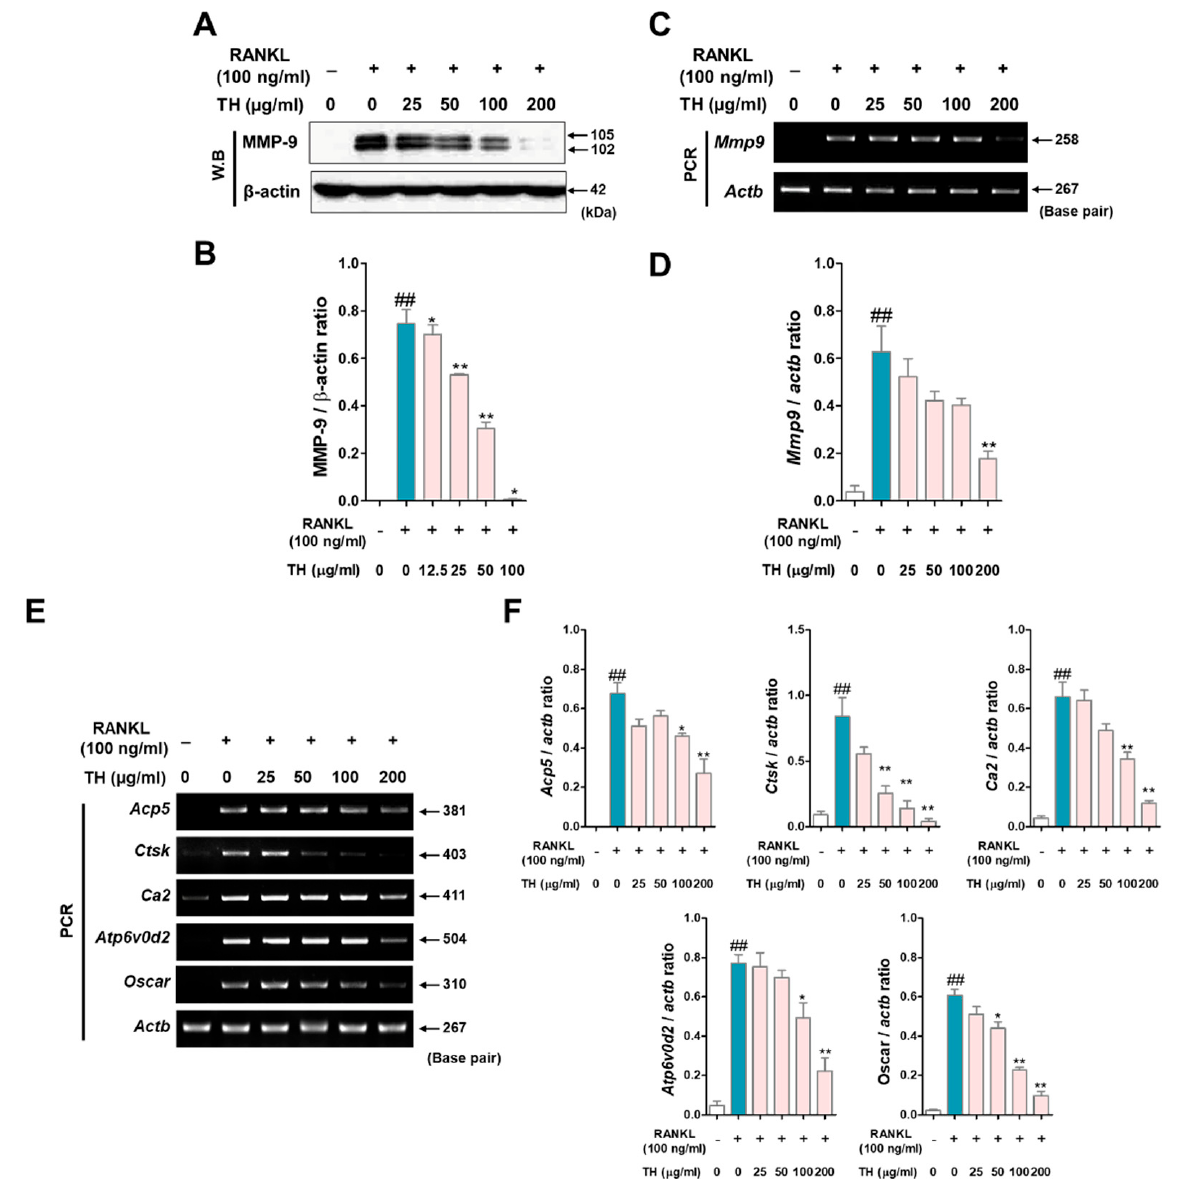
Figure 5. Taraxaci Herba (TH) treatment reduced the mRNA expression of osteoclast-related genes. ( A ) MMP-9 expression was analyzed by Western blot. ( B ) Protein expression was quantified using ImageJ software Ver. 1.46 with Actb ( β -actin). ( C ) Matrix metallopeptidase 9 ( mmp9, MMP-9) expression was analyzed by real time reverse transcription polymerase chain reaction (RT-PCR). ( D ) mRNA expression was quantified using ImageJ software Ver. 1.46 with Actb ( β -actin). ( E ) mRNA expressions of tartrate-resistant acid phosphatase (TRAP) ( Acp5, TRAP), cathepsin K ( Ctks , CTK), ( Ca2, CA2), atpase H+ transporting V0 subunit d2 ( Atp6v0d2, ATP6v0d2), and osteoclast-associated receptor ( Oscar , OSCAR) were measured using RT-PCR. ( F ) Acp5 , Mmp9 , Ctks , Ca2 , Atp6v0d2, and Oscar mRNA expressions were quantified using ImageJ software Ver. 1.46. with glyceraldehyde 3- phosphate dehydrogenase ( Gapdh, GAPDH). The experiments’ representative images are shown, and the graphs are expressed as the mean ± standard error of the mean (SEM; n = 3). ## p < 0.01 vs. normal group; * p < 0.05, ** p < 0.01 vs. control group.